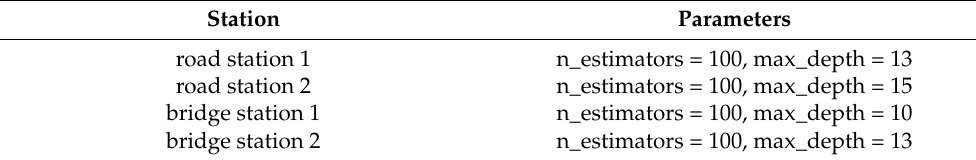
Table 4. The parameters in the random forest model at each